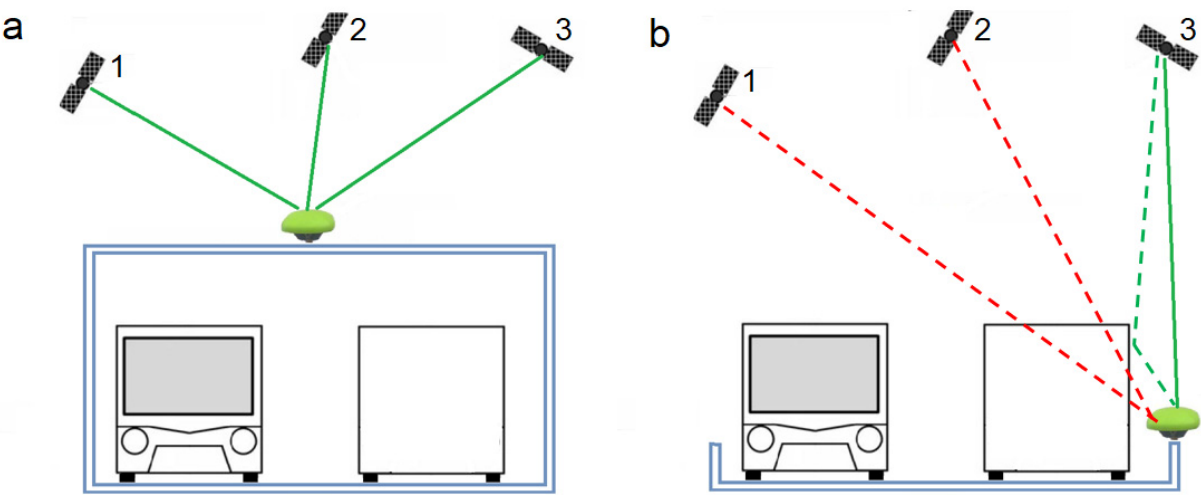
Figure 5. Noise in GPS monitoring of bridges imposed by passing vehicles. ( a ): the GNSS antenna is in an optimal position, and the signal from the satellites (green lines) is not influenced by passing vehicles. ( b ): The GNSS antenna is at a low-level, so that certain passing vehicles produce two effects; first, some satellites are instantaneously shadowed (those shown with dashed red lines); this imposes changes on the observations system and on computed instantaneous coordinates and deflections; second, the signal of some satellites arrives at the GNSS antenna from two paths, directly (continuous green line) and after reflection on the passing vehicle (dashed green line), so that the instantaneous distance between antenna and satellite is modified and spurious instantaneous coordinates are computed. This gives the impression of a much higher or lower deflection, correlating with the passing vehicle. See [28] for details. If the GNSS antenna is located on a stiff, high pole, this double source of noise is avoided (see [29]).